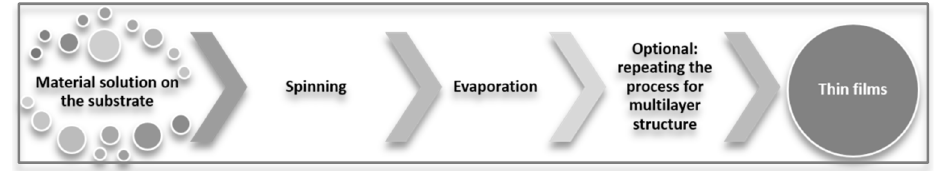
Figure 8. Synthesis scheme of spin-coating method.